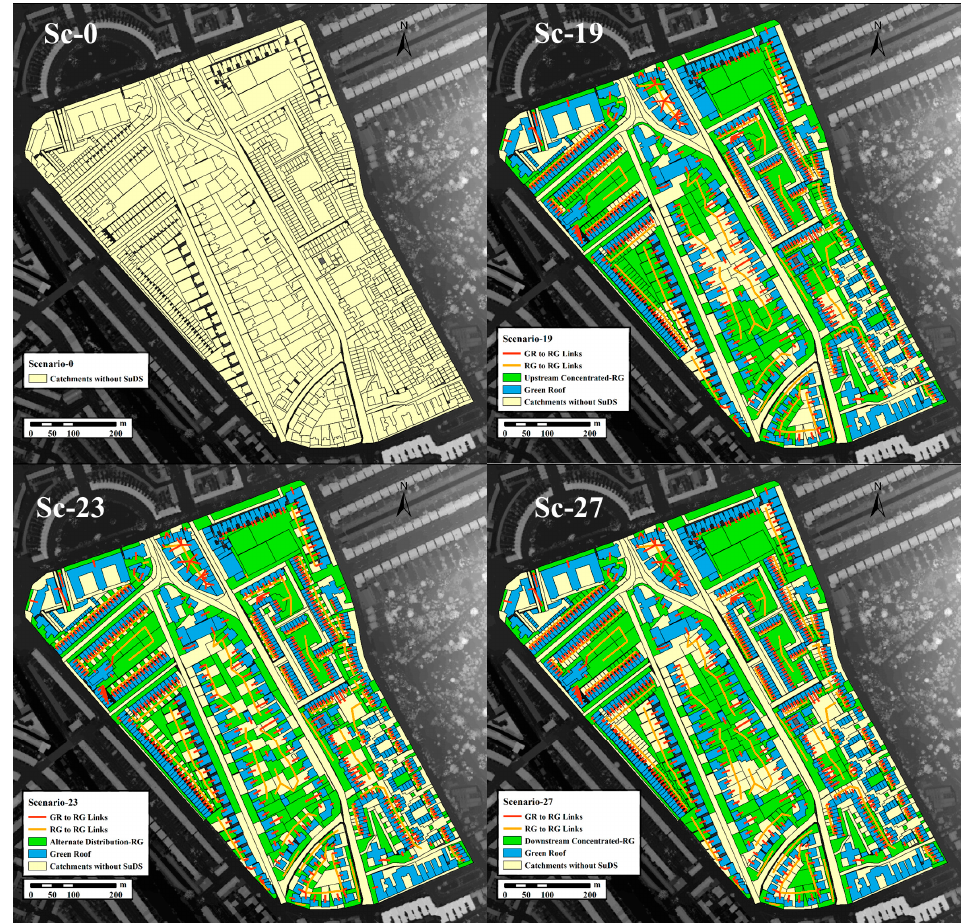
Figure 7. Sketch maps of different position strategies. In scenario 19, RGs are applied in upstream mini-catchments along flow direction; scenario 23, RGs are applied in even-numbered mini-catchments along flow direction; scenario 27, RGs are applied in downstream mini-catchments along flow direction.